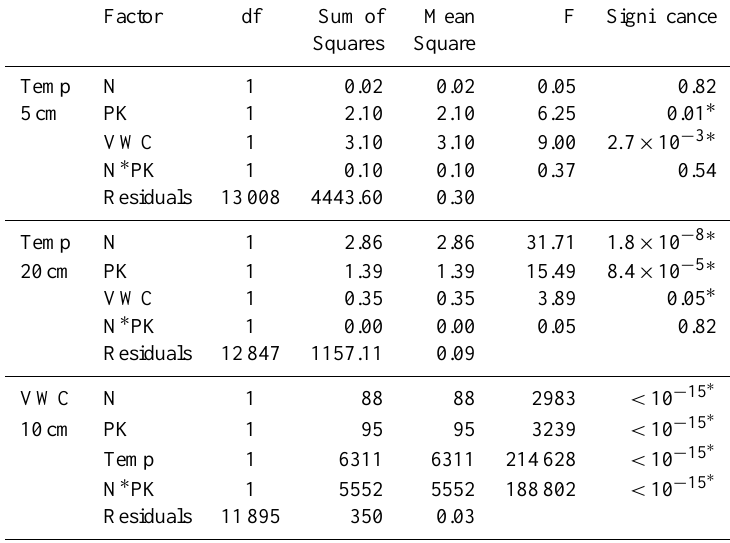
Table 2. Repeated measures analysis of variance ( RM ANOVA) for treatment effects on soil temperatures (“Temp”) and volumetric water content (“VWC”). ∗ Significant at p < 0 . 05, df, degree of freedom. Residuals also noted. Factor df Sum of Mean F Significance Squares Square Temp